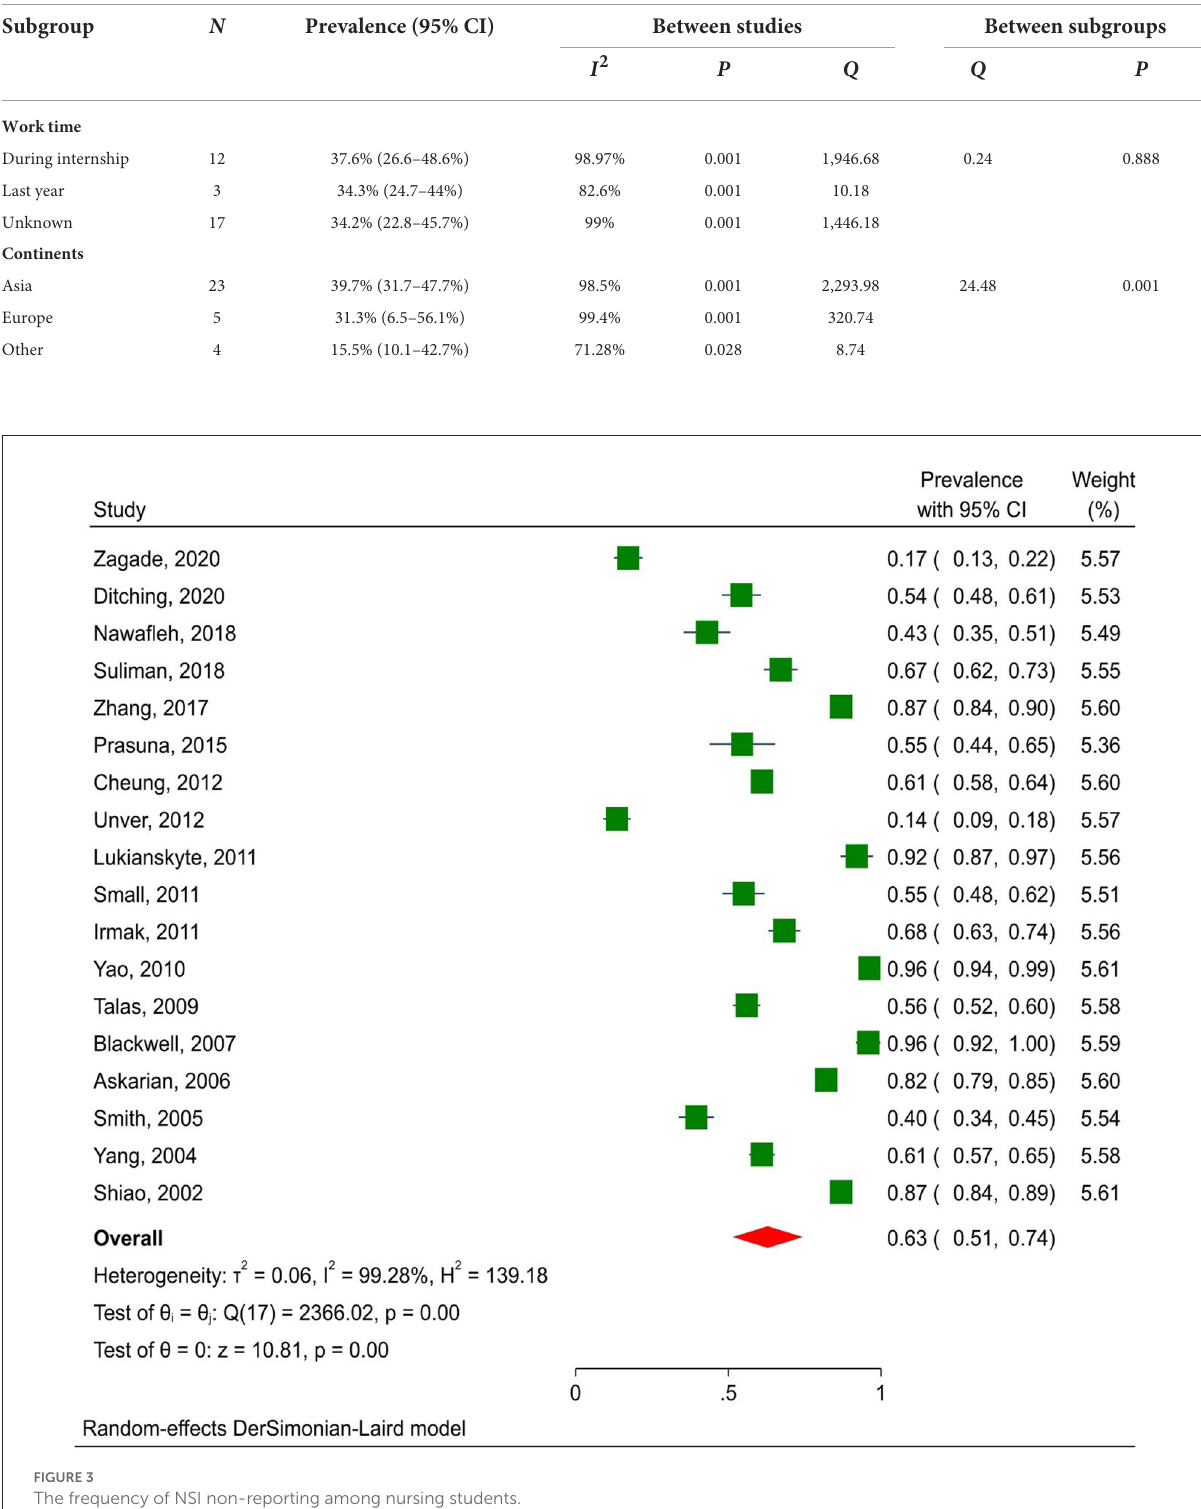
TABLE 2 The subgroup analysis by period and continent.